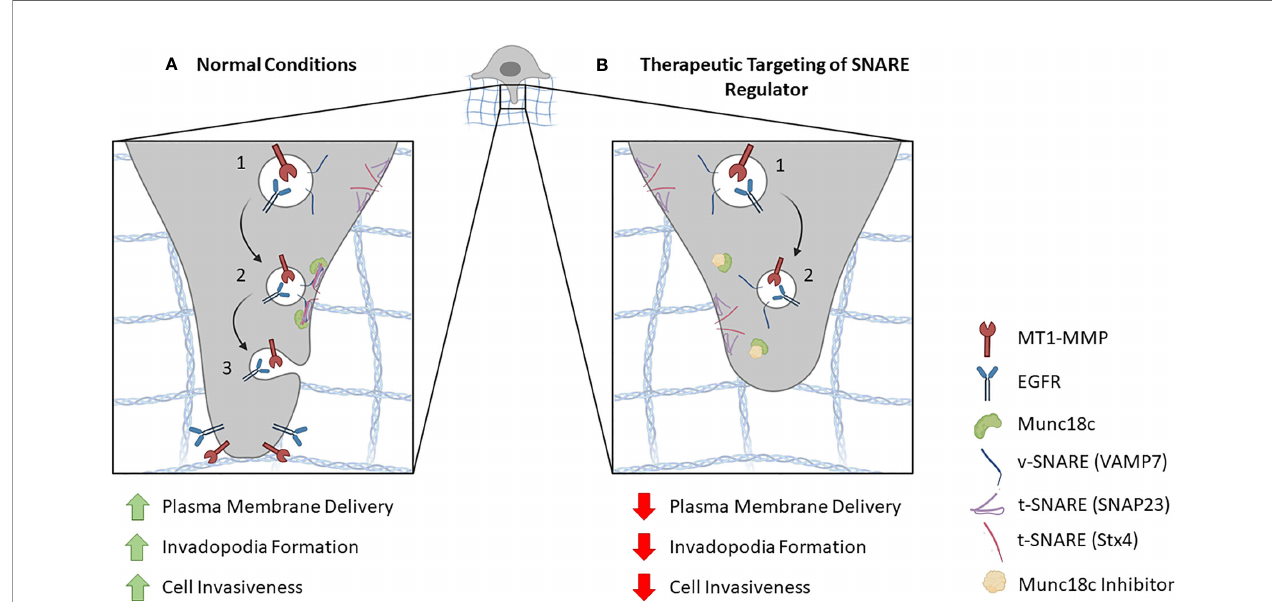
FIGURE 2 | Proposed model for inhibiting SNARE-mediated membrane traf fi cking at invadopodia. (A) In normal conditions, components are delivered to invadopodia sites in a SNARE-regulated manner. (1) For example, vesicles containing MT1-MMP, EGFR and the v -SNARE Stx4 are depicted. (2) When the vesicle reaches its destination, a SNARE complex is formed by the v- SNARE and t- SNAREs (e.g. SNAP23, VAMP7) on the target membrane. This SNARE interaction is facilitated by the SNARE regulatory protein, Munc18c, which primes Stx4 for association with its cognate SNARE partners. (3) SNARE-mediated fusion between the vesicle and the invadopodial membrane results in the delivery of proteins necessary for invadopodia formation and cellular invasion. (B) Potential therapeutic targeting of a SNARE regulatory protein inhibitor. (1) As in A, vesicles containing MT1-MMP, EGFR and the v -SNARE Stx4 are depicted. (2) The presence of a Munc18c inhibitor impairs Stx4 involvement in SNARE complex formation, which reduces membrane fusion and delivery of invadopodial proteins leading to decreased invadopodia formation and cell